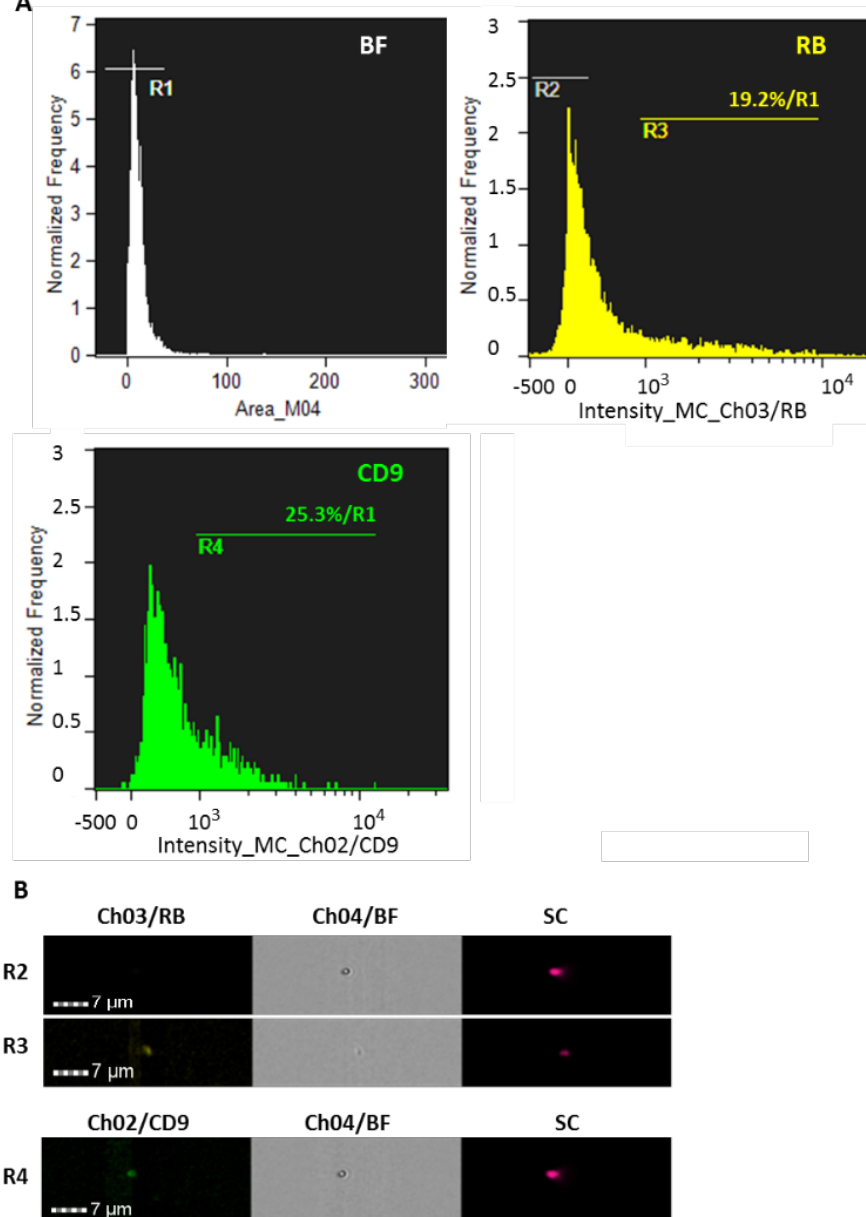
Figure 7. Flow cytometric characterization of exosomes. ( A ) T98G cells were incubated with 12.5 μ M RB under HBSS starvation, which was followed by standard growing conditions (in the presence of exosomes-free FBS) for 24 h. Exosomes were then isolated from cell culture medium and split into two aliquots of 100 μ L. The first aliquot was not further treated, while the remaining one was separately stained with 1 μ g of a rabbit anti-CD9 primary antibody (Cell Signaling, #13174) fluorescently conjugated using a DyLight488 labeling kit (Biorad). After excess dyes removal by Exosome spin columns (MW 3000, Thermofisher), the exosomes aliquots were analyzed by flow cytometry (Amnis Imagestream, Luminex). High gain mode acquisition with 60× magnification was applied to plot particles distribution according to their size (Area_M04), thus defining the R1 gate. Plot distribution of RB intensity (Ch03) was reported, where R2 and R3 gates represented negative to faint fluorescence signals, and detectable RB particles, respectively. Plot distribution of CD9 intensity (Ch02) was reported, with the R4 gate representing florescent detectable CD9+ par- ticles. For each plot, percentages of florescent detected particles on the R1 gate were reported. ( B ) Examples of image galleries within the indicated gates – channels are reported. Additional images are shown in Figure S6. BF = bright field; SC = size scatter. A total of 25,000 particles for each anal- ysis was acquired.